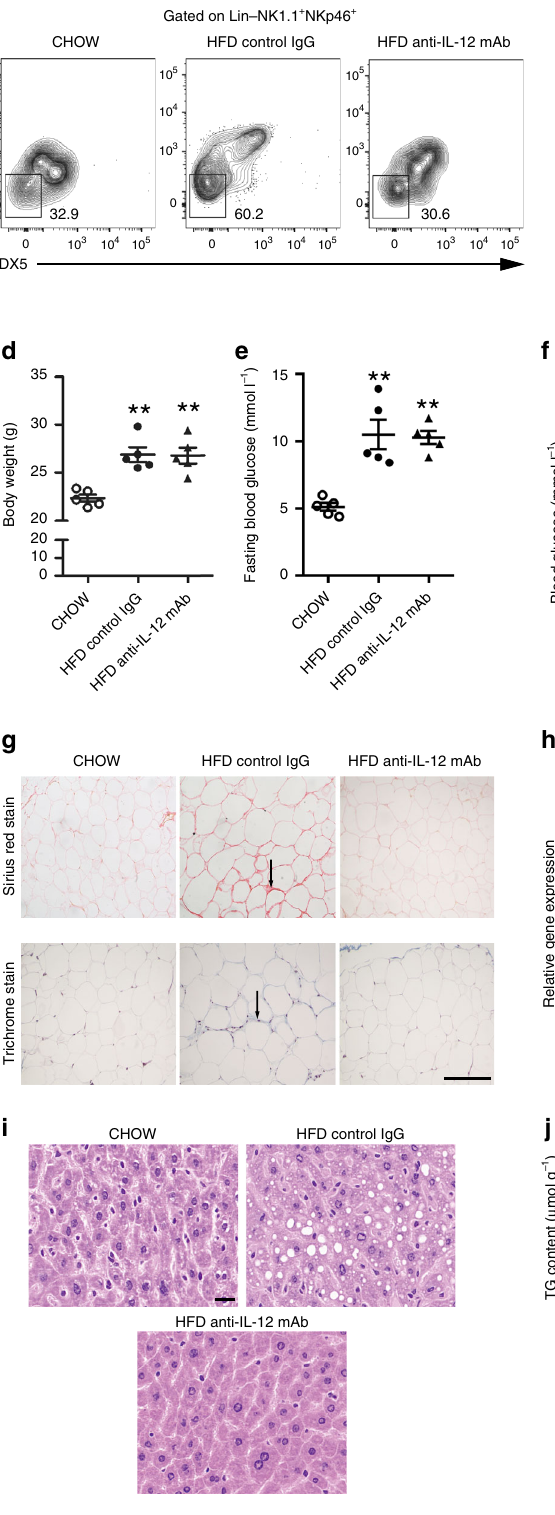
fi brosis by adipose ILC1 is related to the regulation of macrophage and activation of the TGF- β 1/pSmad3 signaling pathway. Fibrogenesis is a complex process caused by a variety of cells, such as myo fi broblasts, macrophages, and parenchymal cells. Pre- vious studies showed that myo fi broblasts are derived from different cell types including resident fi broblasts and fi brocytes, depending on different tissues or organs 25 . In adipose tissue,